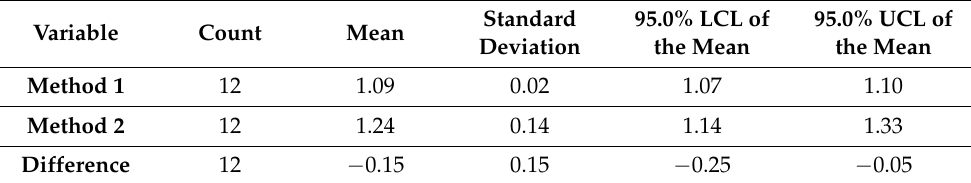
Table 3. Descriptive statistics.